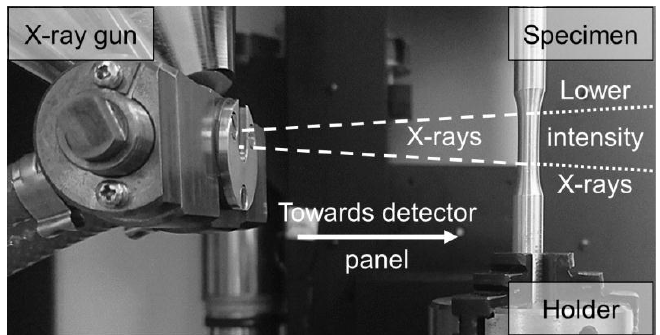
Figure 2. The experimental setup of X-ray microcomputed tomography (µ-CT) for scanning fatigue specimens.